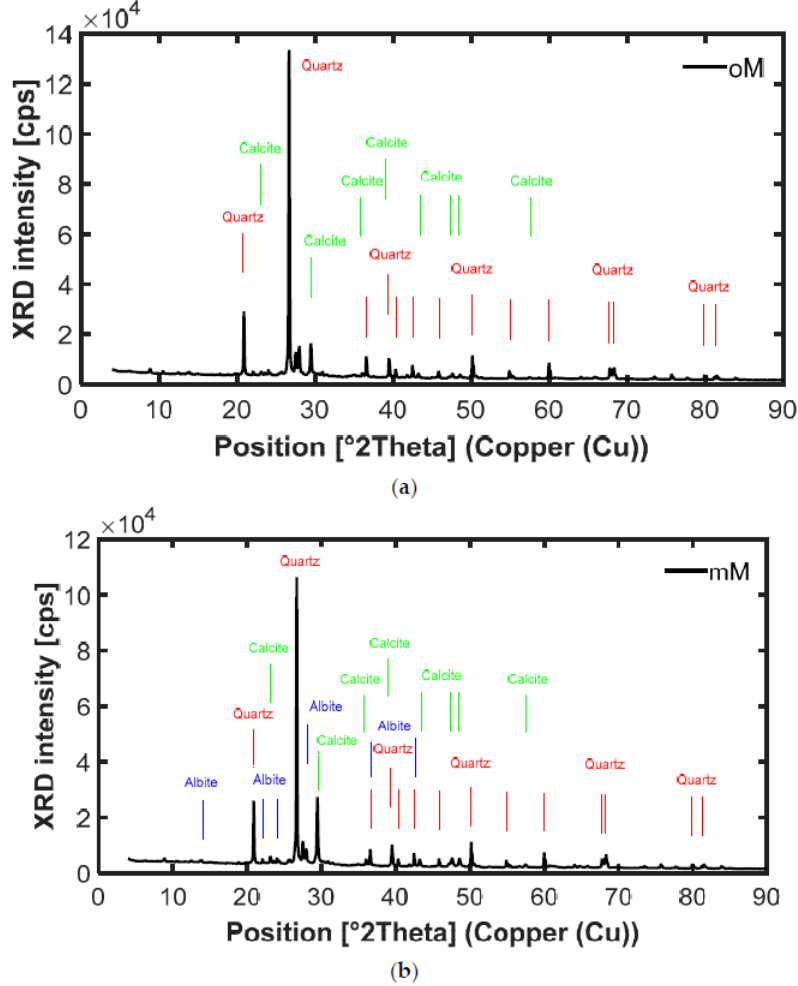
Figure 4. XRD plots of the till soils: ( a ) oM; ( b )